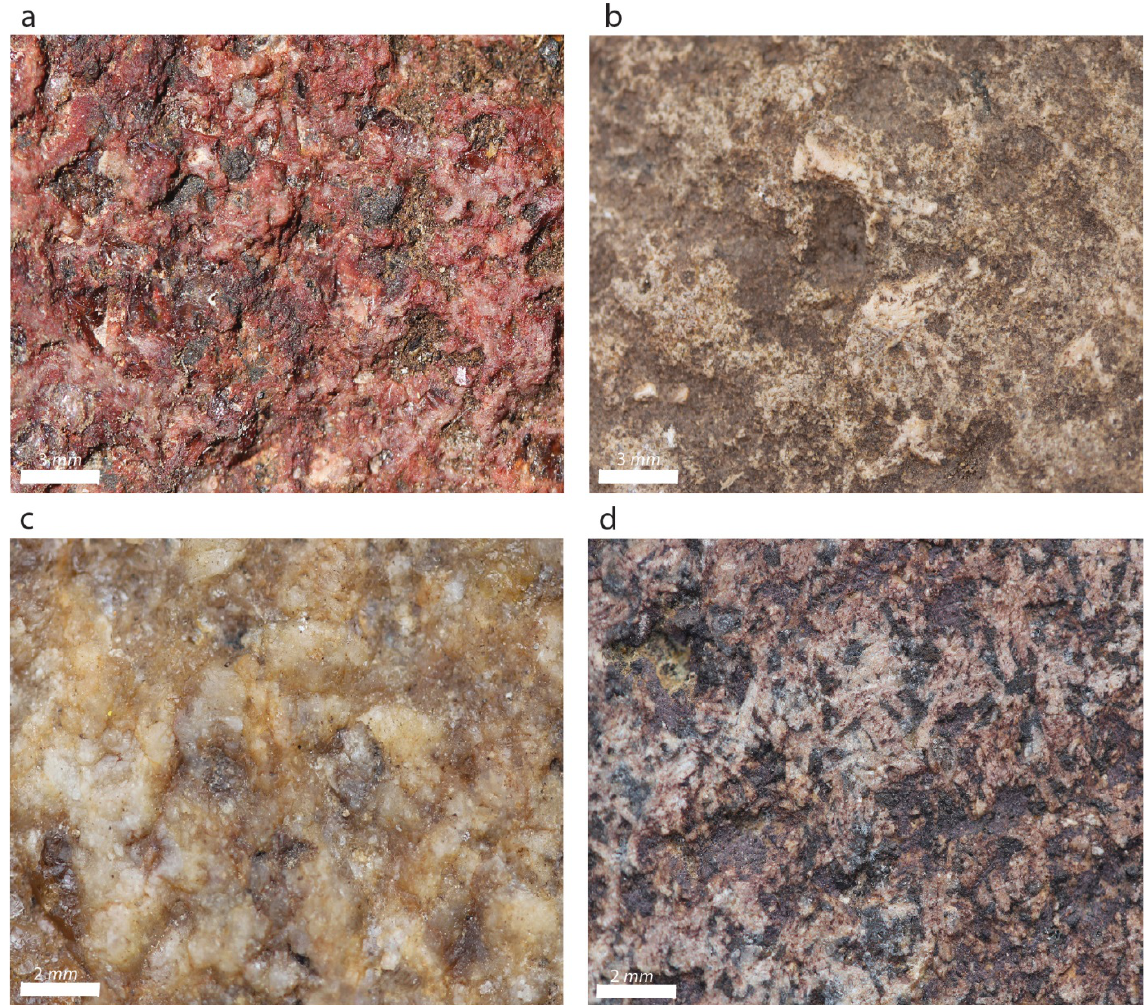
Figure 19. Macro-photographs (x10 and x15 magnification) of the active surfaces of handstones and querns showing different use-wear. a) Crushing buna (quern reserved for buna ). Debris remains in the interstices of the active surface. b) Crushing buna and manipulation (handstone reserved for buna ). Debris is still visible in the interstices. c) Crushing spices with a handstone on a quern reserved for buna and spices. d) Crushing and milling dirt (surface of a quern). (Scale bars: a. 3 mm, b. 3 mm, c. 2 mm, d. 2